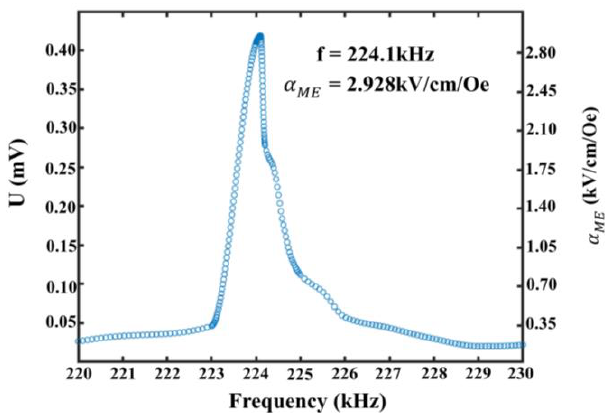
Figure 6. MEMS magnetoelectric antenna output signal and ME coefficient.